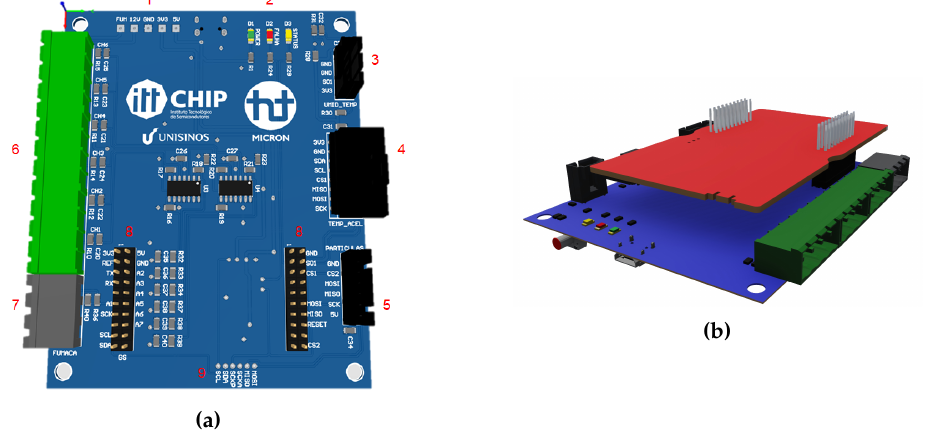
Figure 2. ( a ) Integration board that is able to receive data from up to 16 sensors; ( b ) IoT node composed of an integration board and a communication